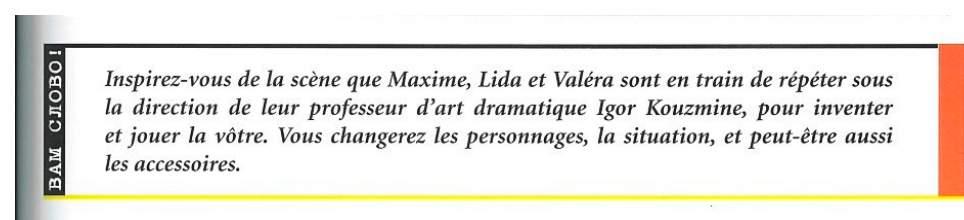
Figure 2. Example 2 of a task in Reportazh